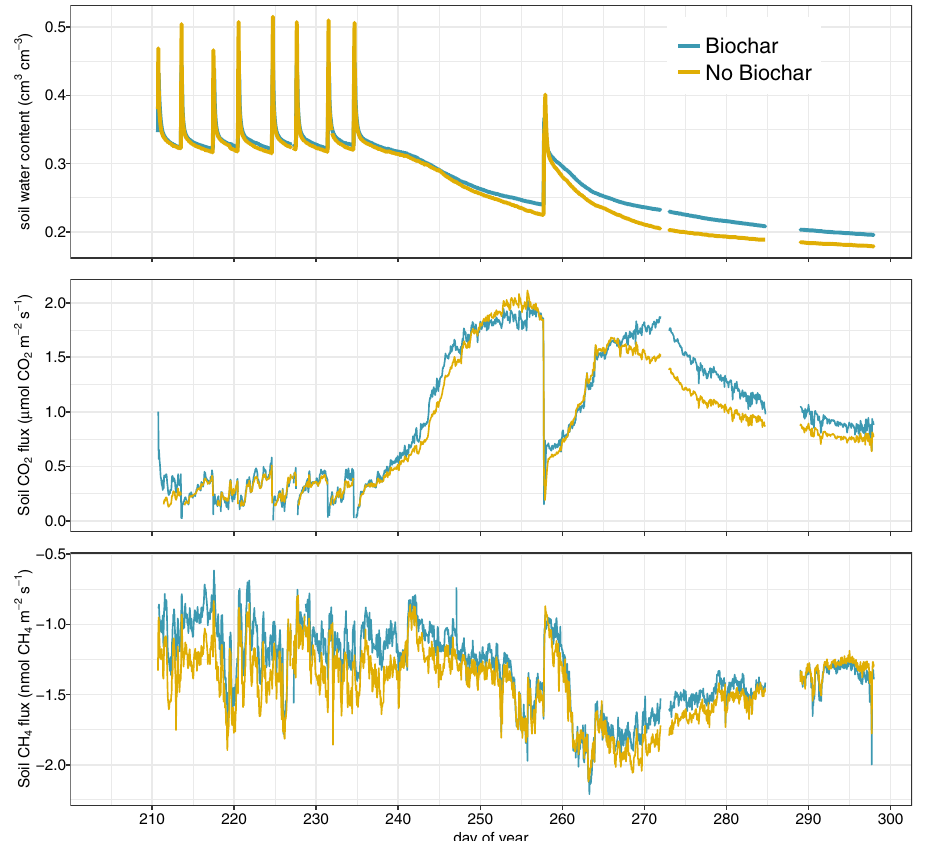
Figure 2. Temporal dynamics of soil water content and soil gas fluxes of CO 2 and CH 4 for Biochar and No Biochar